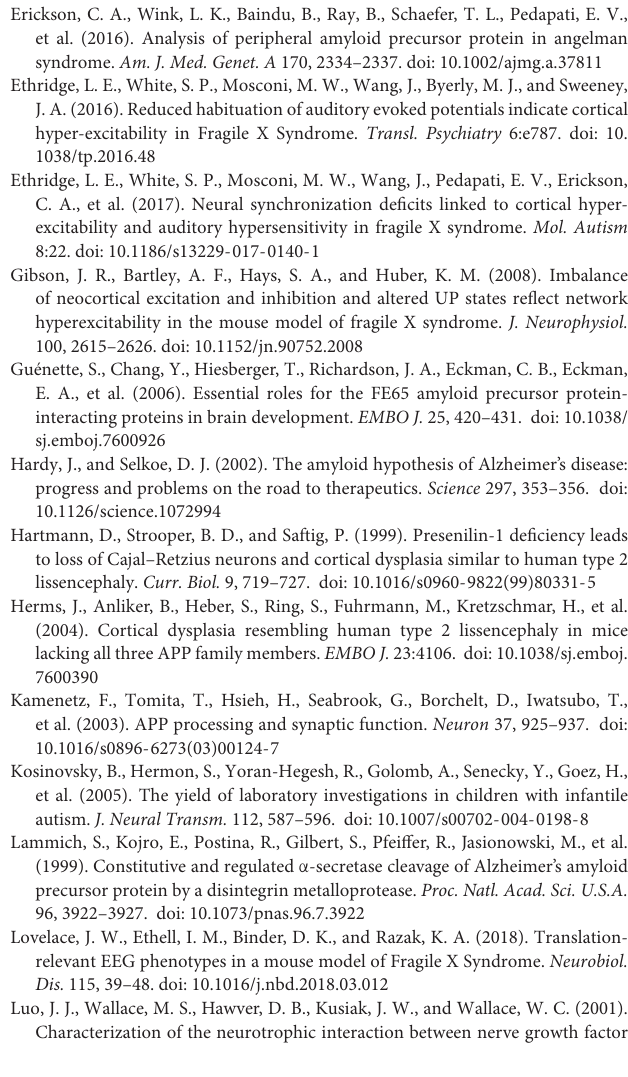
TABLE S1 | Dilution factors and lower limits of detection for each ELISA. Prior to analysis, all analyte concentrations were optimized per ELISA plate. All samples were run with the dilutions listed in the table. TABLE S2 | Analytes only significantly varied with respect to group. Levels of all analytes were captured by ELISA and analyzed with respect to group. Only sAPP α , A β (1–40), and A β (1–42) were significantly different between groups. No significant Sex ∗ Group interactions were found for any of the analytes tested ( p > 0.05). TABLE S3 | Metabolite concentrations did not correlate significantly with their respective processing enzymes. The relationship between levels of APP metabolites and enzymes were examined with respect to group using generalized linear models with lognormal regression. No correlates were found to be significant ( p >